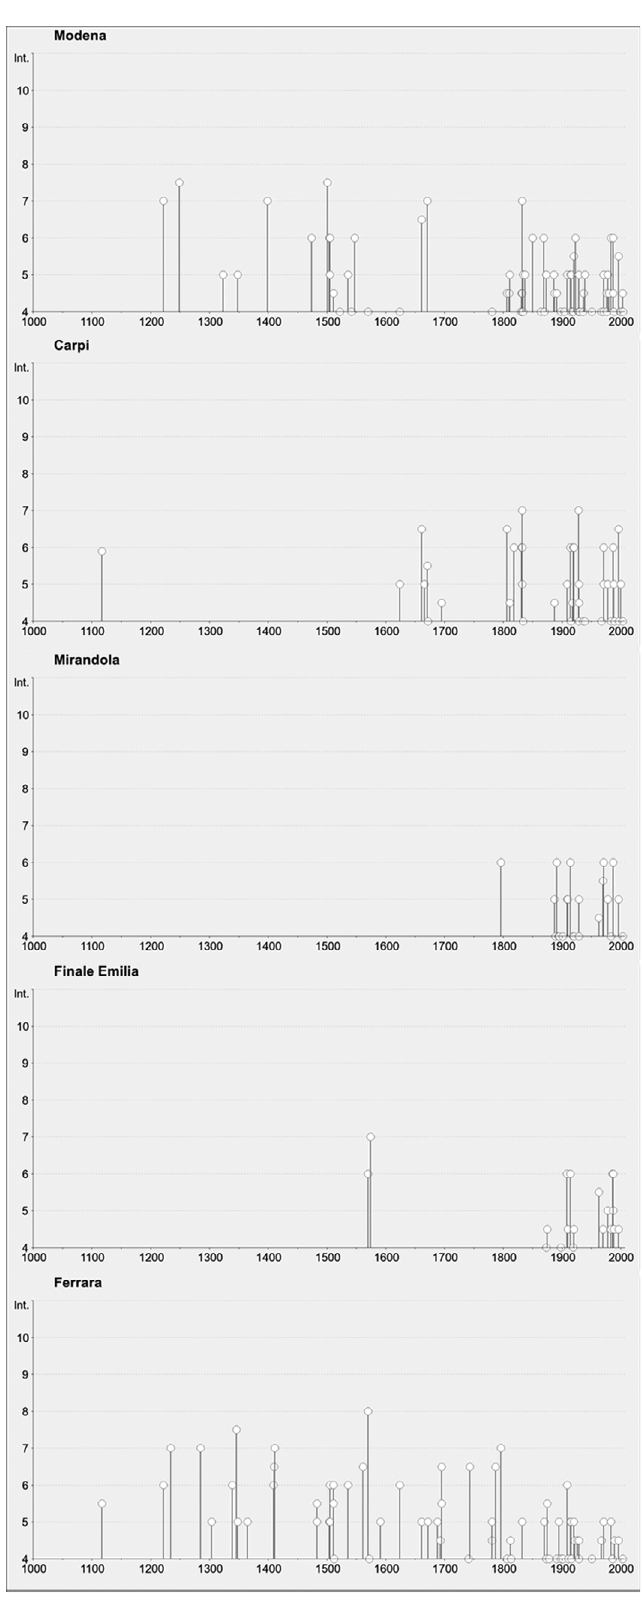
Figure 2. Comparison between seismic histories [from Locati et al.